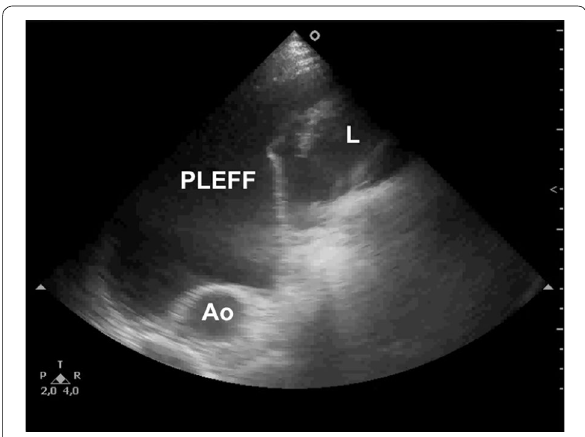
Fig. 3 Massive left-sided pleural effusion with floating fibrin deposition. PLEFF pleural effusion, Ao aorta, L lung